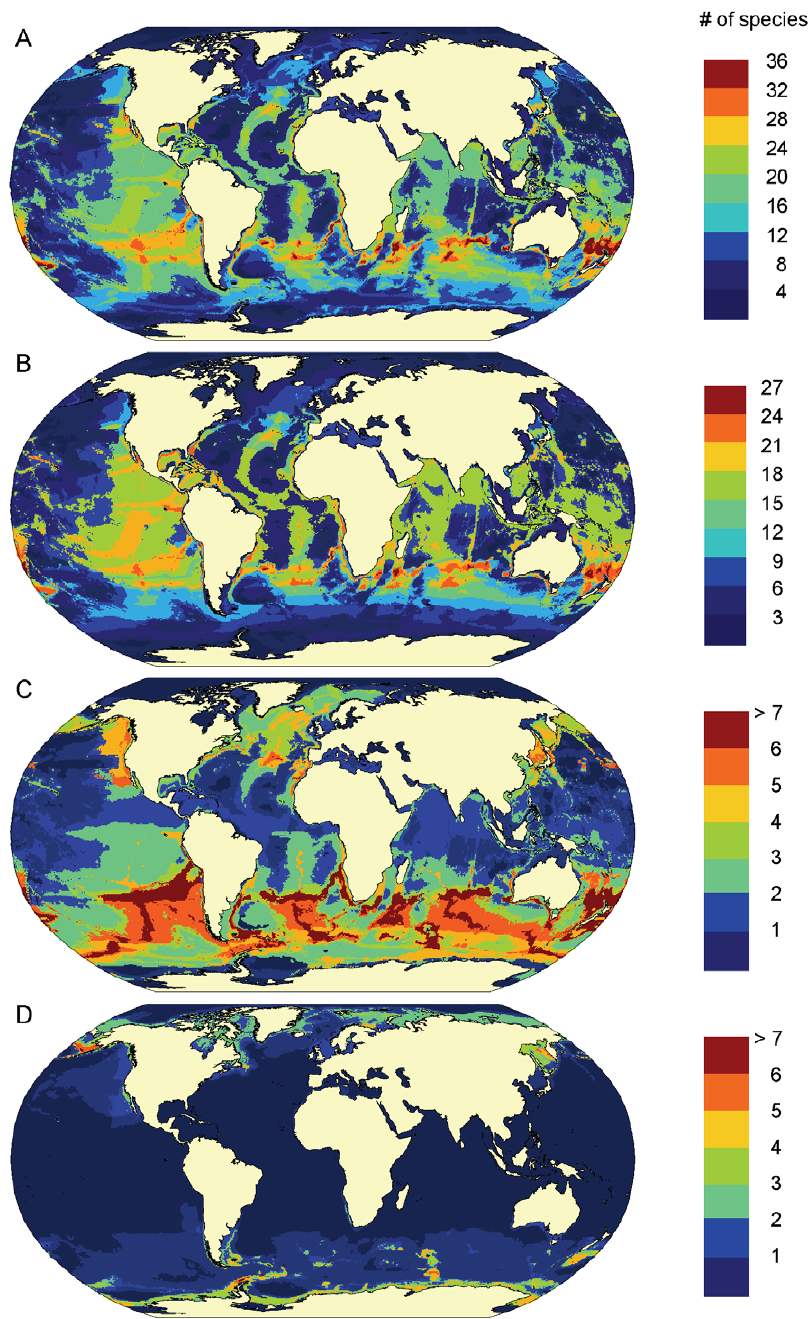
Figure 1. Predicted patterns of marine mammal species richness. A. All species (n=115), B. Odontocetes (n=69), C. Mysticetes (n=14), D. Pinnipeds (n=32). Colors indicate the number of species predicted to occur in each 0.5 u x0.5 u grid cell from a relative environmental suitability (RES) model, using environmental data from 1990–1999, and assuming a presence threshold of RES . 0.6. doi:10.1371/journal.pone.0019653.g001 Significant linear relationships were seen across a wide range of amounting to only 16% of the total number of predicted species different rarefaction bases and RES presence thresholds (Table or 6 2 species on average (Table 2). This indicates that predicted S1). Presence thresholds associated with the most parsimonious estimates of absolute species richness appear to be relatively models (lowest AIC) varied among survey areas and rarefaction robust across a range of thresholds. For display purposes we used bases, ranging between 0.25 , RES , 0.75, making the selection of the RES threshold . 0.6, associated with the second lowest AIC a single best threshold somewhat subjective. However, the for all surveys combined at rarefaction basis n = 50 (i.e. expected variation in species richness predicted for each 5 u cell across this species per 50 sightings). This threshold was associated with the range of RES thresholds was relatively small on average, lowest possible ES basis to ensure the widest possible geographic